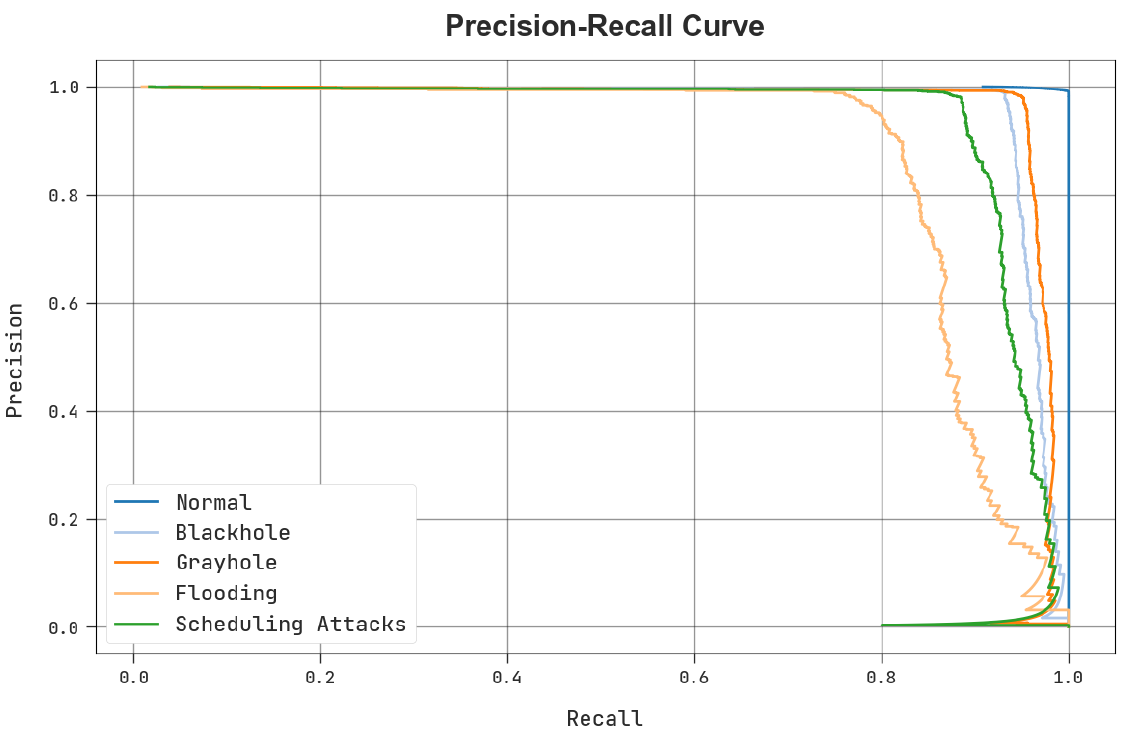
Figure 8. The precision-recall outcome of the BCOA-MLID approach.